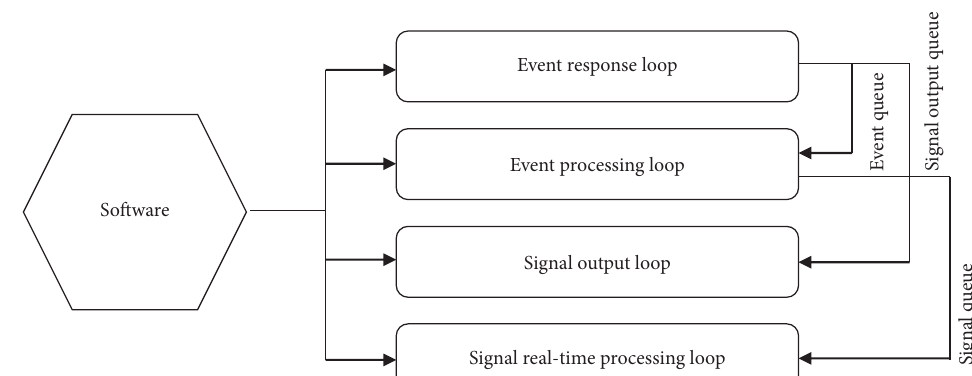
Figure 2: Software running